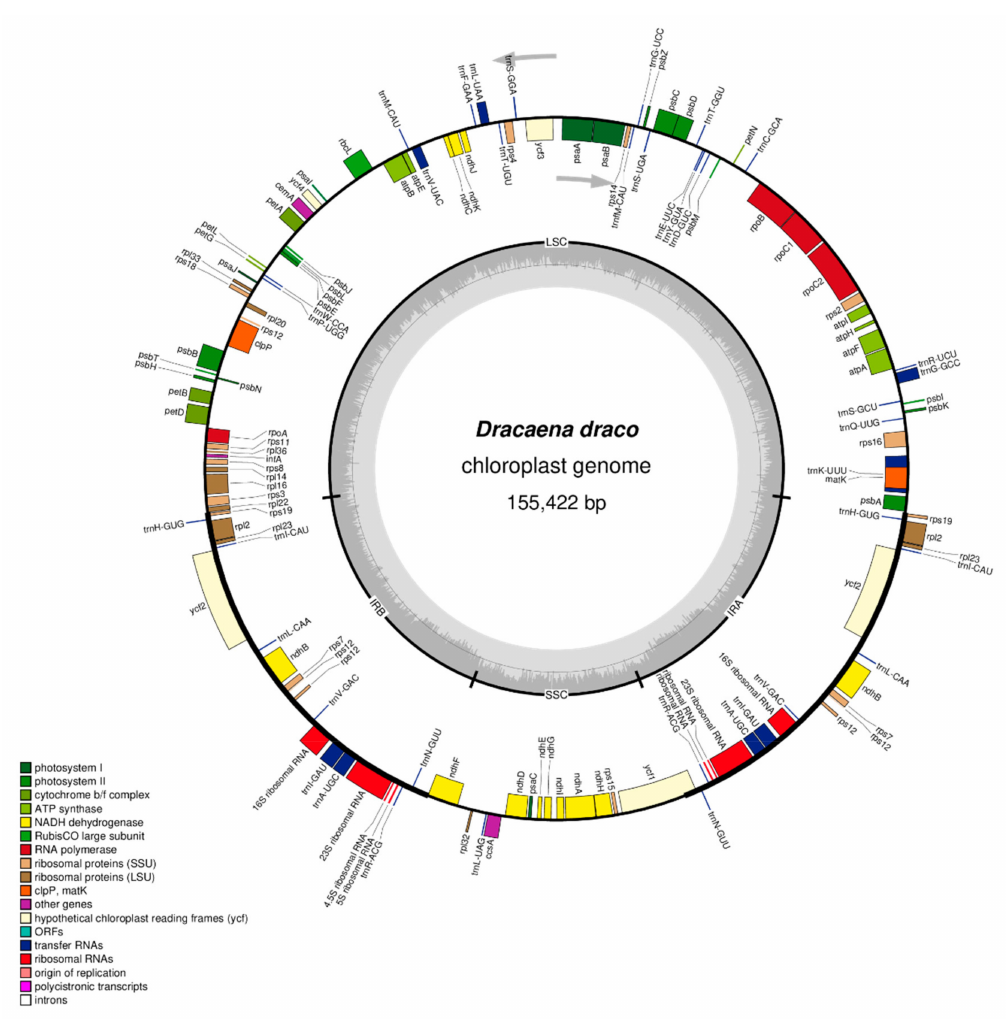
Figure 1. Map of the chloroplast genome of D. draco . The genes inside the circle are transcribed clockwise, and those outside are transcribed counterclockwise. Genes of di ff erent functions are color coded. The darker gray in the inner circle shows the GC content, while the lighter gray shows the AT content. IRA, IRB, inverted repeats; LSC, large single copy region; SSC, small single copy region. The LSC region is 83,942 bp, whereas the SSC region is 18,472 bp. The complete chloroplast genome of D. draco is 155,422 bp in length (GenBank acc. MN990038). The total percentage of GC content is 37.6% and ranges from 31.2% in the SSC region, through 35.6% in the LSC region to 42.9% in the IR regions. Slightly higher GC content in IR regions is likely due to duplicate ribosomal